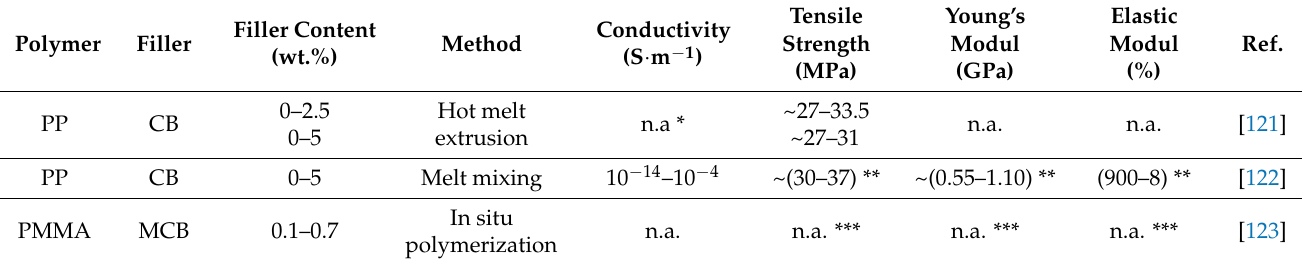
Table 7. Electrical conductivity and mechanical properties of CB/polymer nanocomposites.